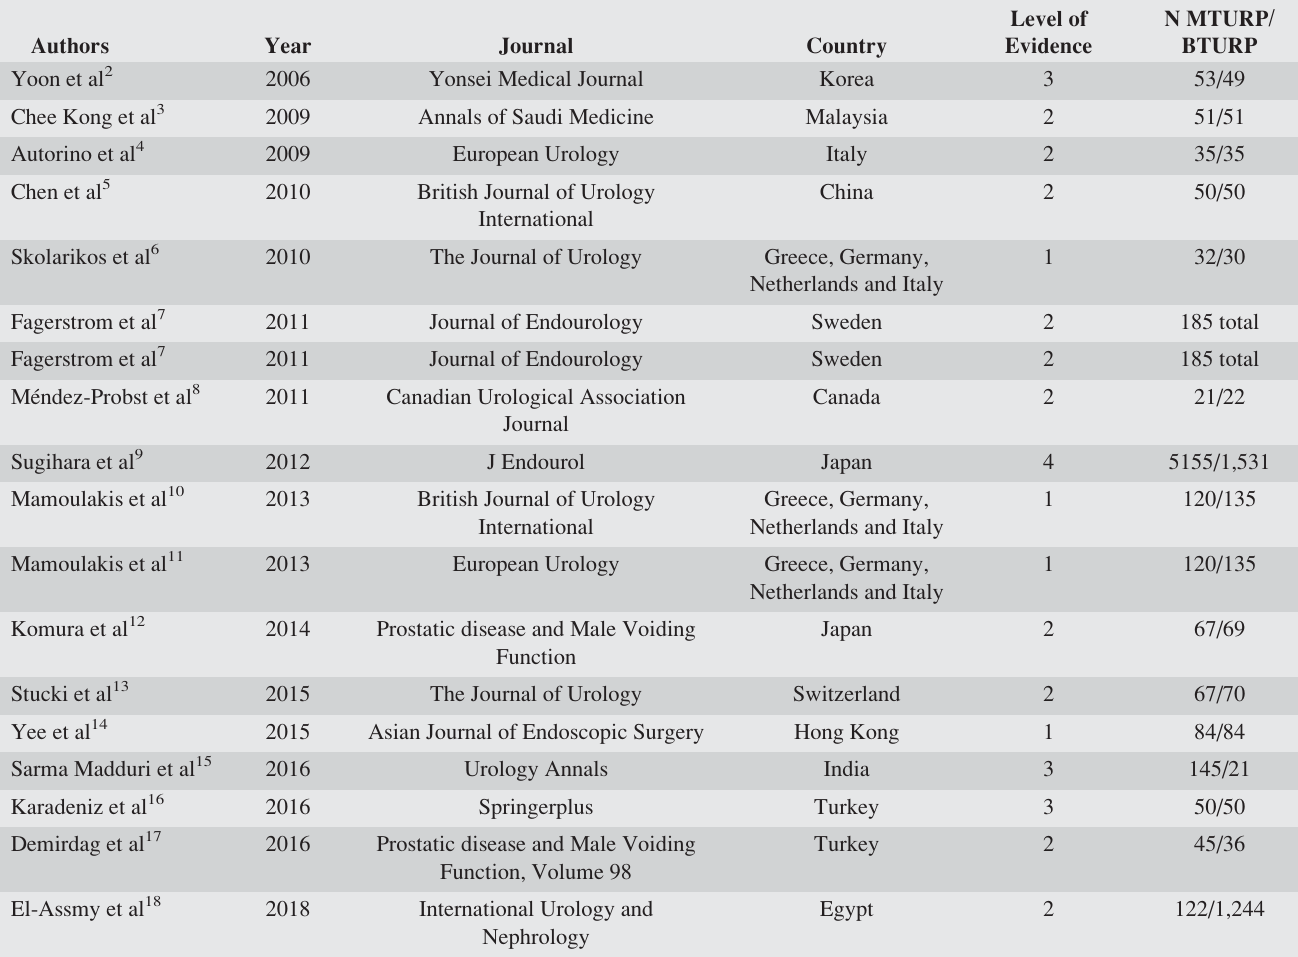
Table 1. A Brief Overview of Papers Included and Their